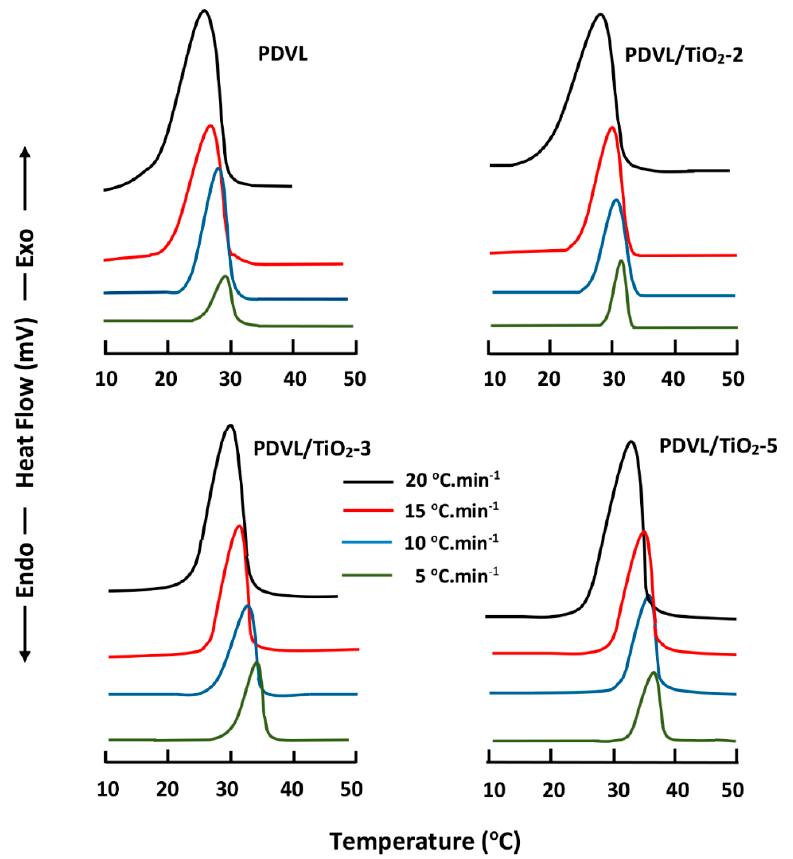
Figure 6. DSC thermal curves of pure PDVL and PDVL/TiO 2 hybrid systems with different TiO 2 contents obtained with different cooling rates.